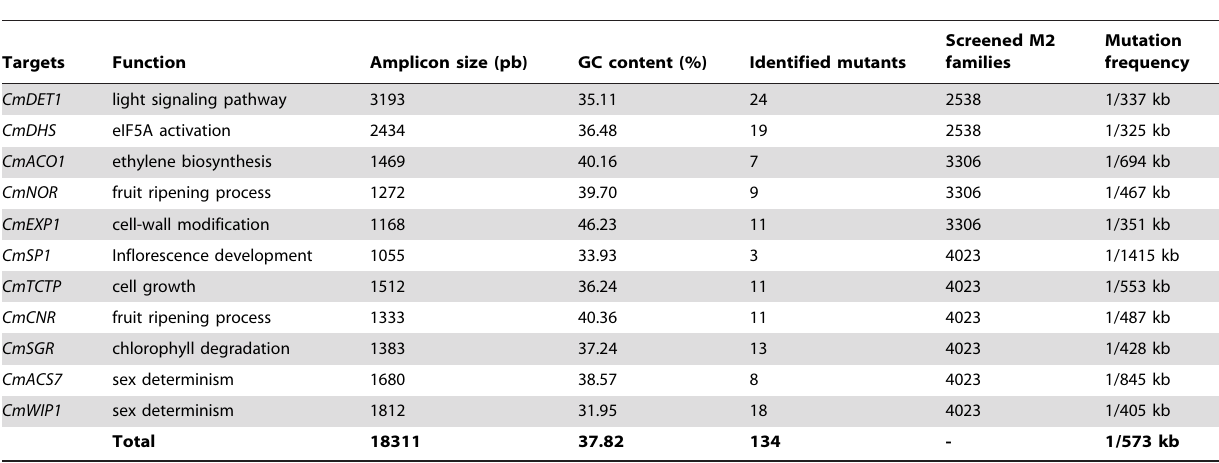
Table 2. Tilled genes and mutation frequency in CharMono mutant population.